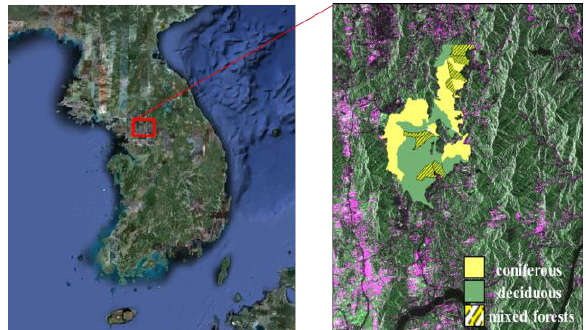
Fig. 1. ALOS PALSAR FBD34 composite of HH/HV/HV, image data acquired on March 20, 2007 over the KEF study area overlaid with forest stand boundaries(center), DEM data(right).